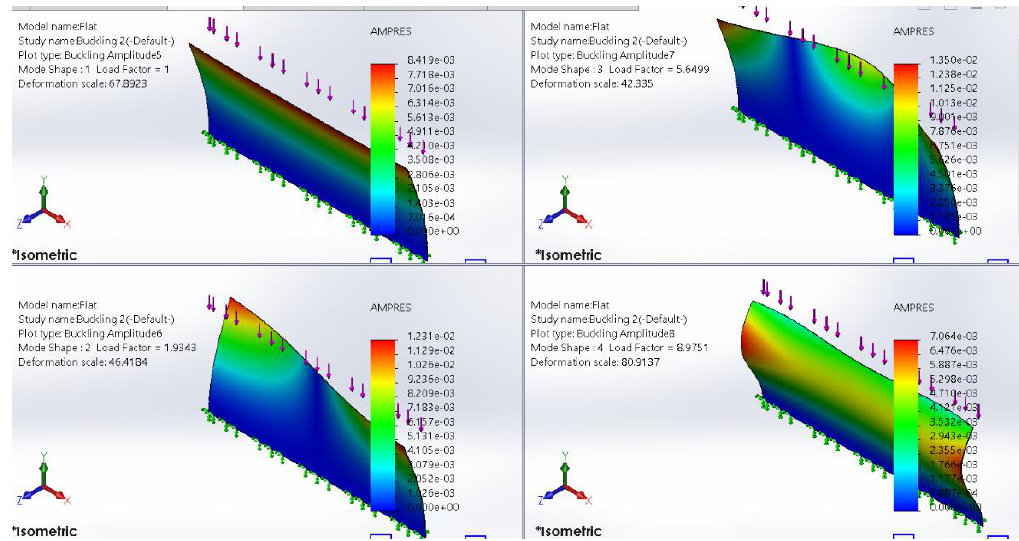
Figure 37: Buckling characteristics of the flat